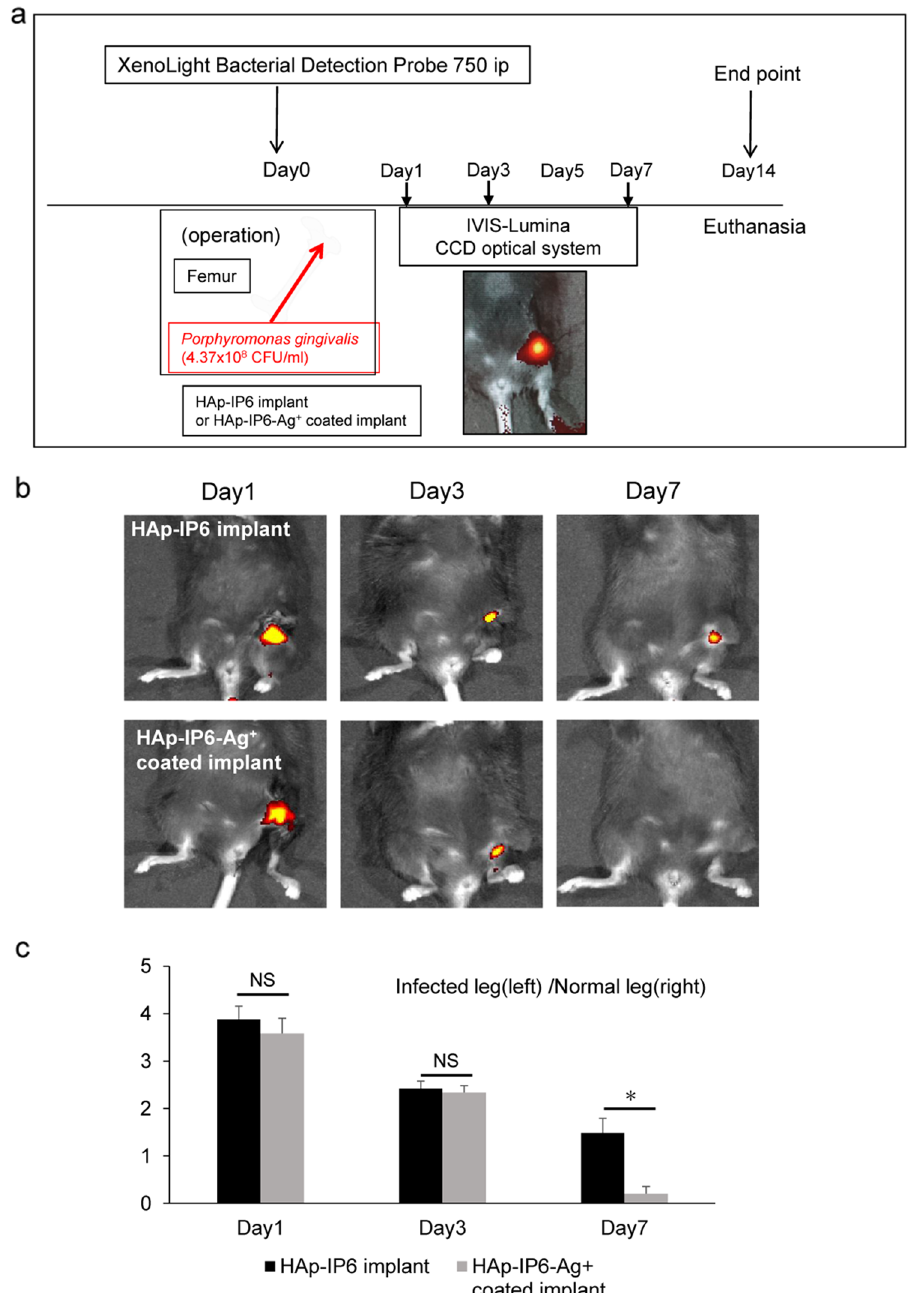
Figure 3. Establishment of a mouse osteomyelitis model. ( a and b ) Experimental protocol. 4.37 × 10 8 CFU/ ml Porphyromonas gingivalis ( P. gingivalis ) were transplanted into femoral bone marrow cavities with titanium rods in eight-week old wild-type mice. Specifically, a skin incision was made over the left knee, and the distal femur exposed. A drill and 23G needle were used to make a hole at the distal end of the femur, and a 0.5 × 8-mm titanium alloy bar was inserted into the mouse femur along with an inoculation of P. gingivalis . Simultaneously, mice were intraperitoneally injected with a NIR-fluorescent bacterial detection probe. ( c ) Shown are NIR- fluorescence signals at infected areas as detected by a bacterial probe on indicated days in indicated mice. HAp- IP6-Ag + group, N = 6; control Ti-HAp-IP6 group, N =